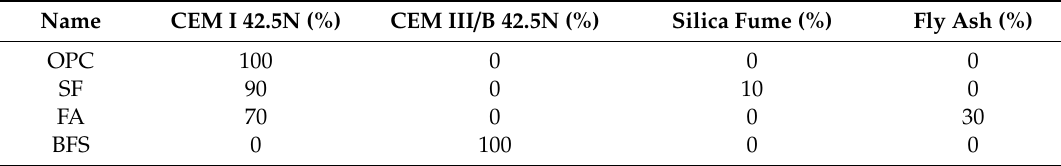
Figure 7. Chemical shrinkage as a function of age. Table 4. Mixture composition of Portland cement and blended cement (% by